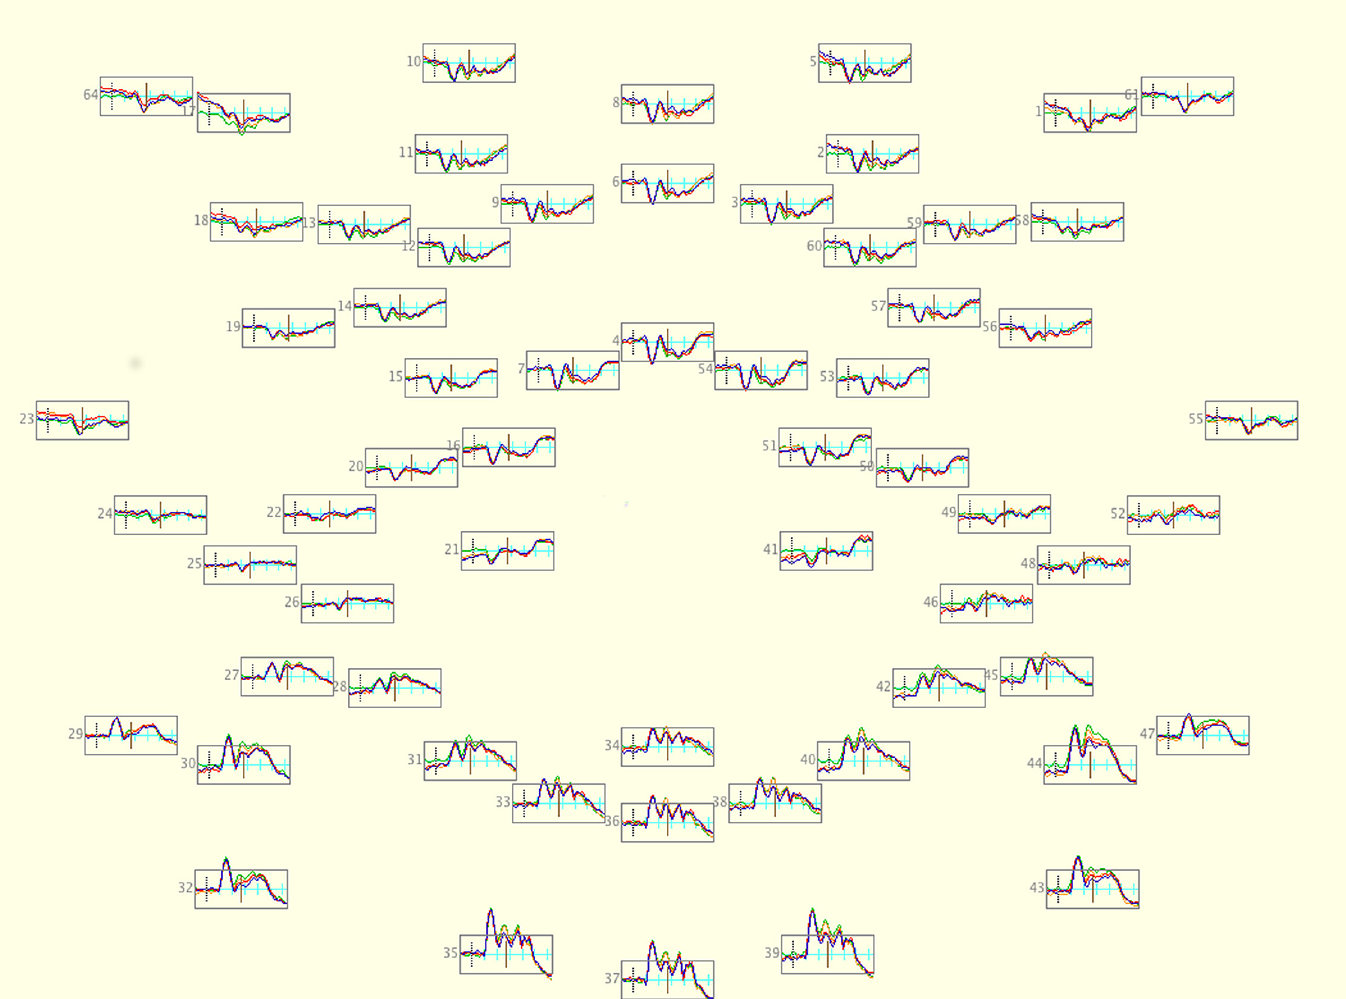
Fig 4. A plot displaying the ERP responses recorded in each condition across the entire scalp. Each box represents a single channel (with the exclusion of electrodes placed on the cheeks to measure eye movements and the vertex electrode) and is bounded vertically at-5 μ v and 5 μ v, horizontally at- 100ms and